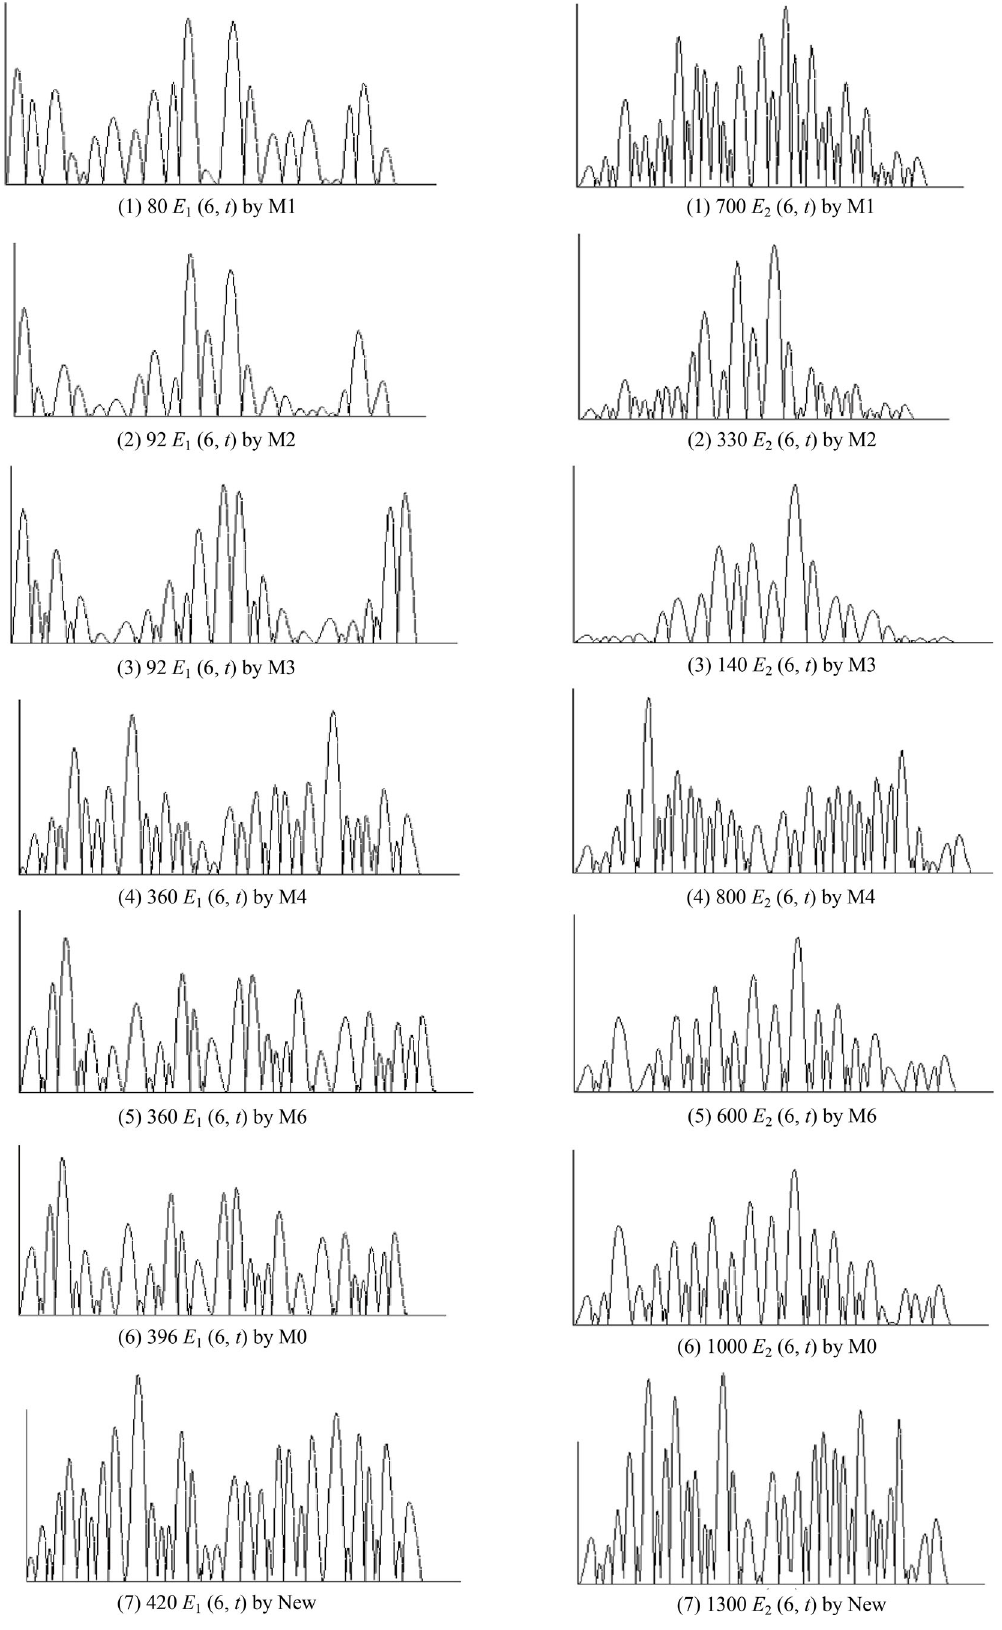
Fig. 5 Error curves for six